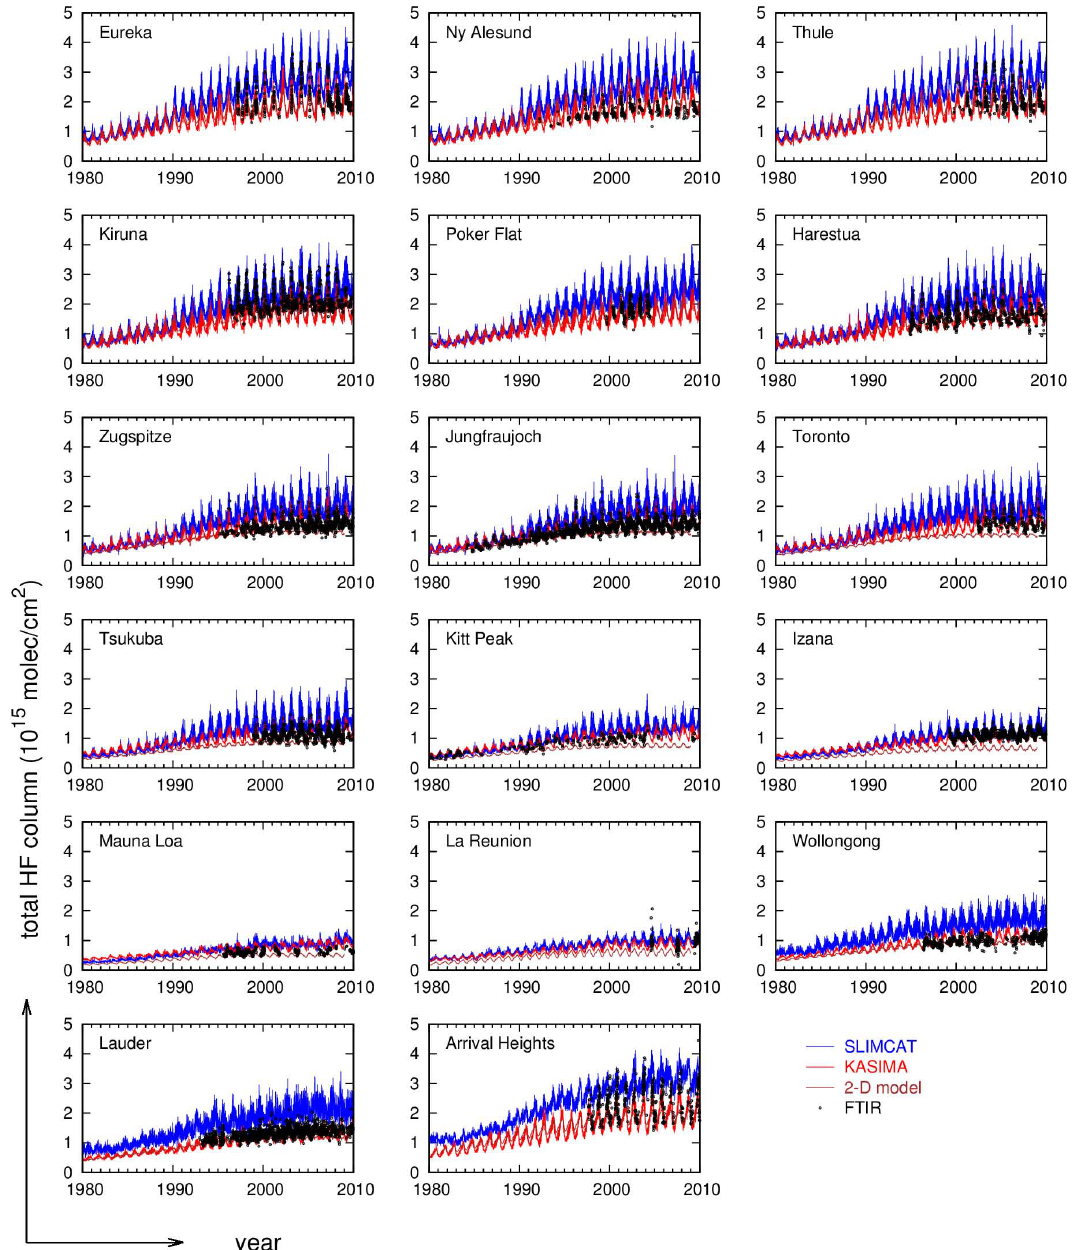
Fig. 5. Time series of HF total column abundances in molecules per cm 2 at the different sites as measured by FTIR (black dots) and simulated by SLIMCAT (blue line), KASIMA (red line), and Bremen 2-D model (brown